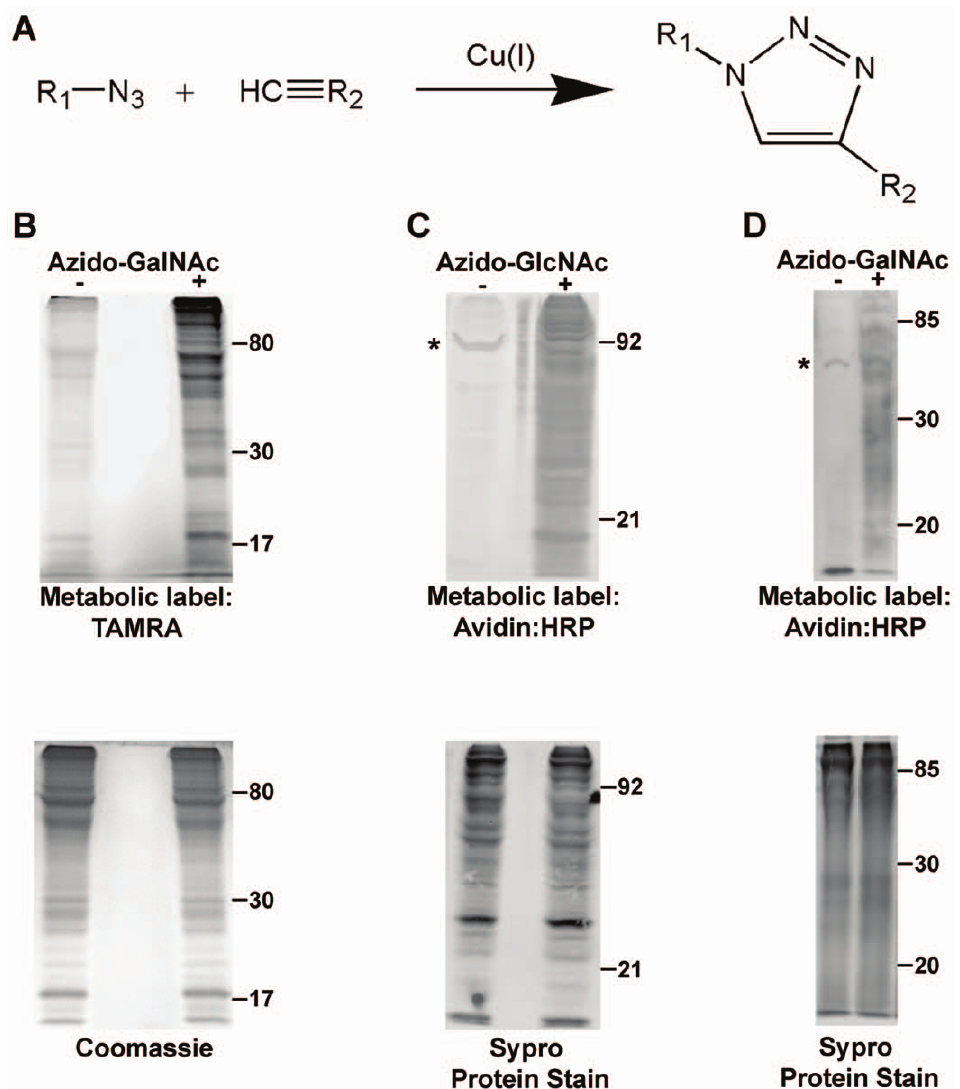
Figure 1. Primary C.elegans cells metabolically incorporate azido-GalNAc and azido-GlcNAc into cellular and secreted proteins. (A) During copper-catalyzed azide-alkyne cycloaddition (‘‘Click Chemistry’’), a covalent bond is formed between a terminal alkyne and an azide group. This reaction can be used to covalently label glycoproteins with biotin or fluorescent tags. This occurs when the R 1 group attached to the azide is a monosaccharide linked to a glycoprotein and the R 2 group attached to the alkyne is biotin or a fluorophore (e.g. TAMRA). (B) N2 cells were cultured with 40 m M GalNAc ( 2 ) or 40 m M azido-GalNAc ( + ) and cell lysates were reacted with TAMRA-alkyne by Click Chemistry. Metabolically labeled proteins were detected by TAMRA fluorescence, and protein loading was verified by Coomassie gel staining. (C) N2 cells were cultured with 40 m M GlcNAc ( 2 ) or 40 m M azido-GlcNAc ( + ) and cell lysates were reacted with biotin-alkyne by Click Chemistry. Metabolically labeled proteins were detected by avidin-HRP with AEC (colorimetric detection), and protein loading was verified by staining with the fluorescent protein stain, Sypro. (D) Conditioned media collected from primary embryonic N2 cell cultures grown without serum in the presence of 40 m M GalNAc ( 2 ) or 40 m M azido- GalNAc ( + ) was reacted with biotin-alkyne. Metabolically labeled secreted proteins were detected by avidin-HRP with ECL, and protein loading was verified by Sypro staining. Asterisk in (C) and (D) marks a known 83 kDa endogenous avidin-binding protein [34].